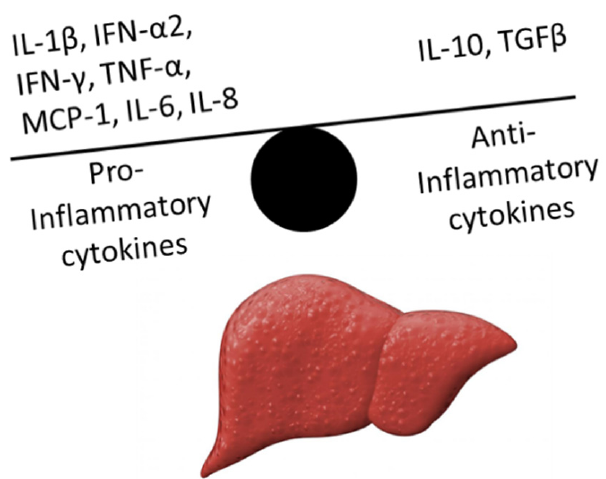
Figure 1. Cytokine disbalance in acute-on-chronic liver failure (ACLF). In ACLF, proinflammatory cytokines outnumber anti-inflammatory cytokines, giving rise to systemic inflammation (IL-1 β , interleukin 1 beta; IFN- α 2, interferon alpha-2; IFN- γ , interferon γ ; TNF- α , tumor necrosis factor- α ; MCP-1, monocyte chemoattractant protein 1; IL-6, interleukin 6; IL-8, interleukin 8; IL-10, interleukin 10; TGF β , transforming growth factor β ).